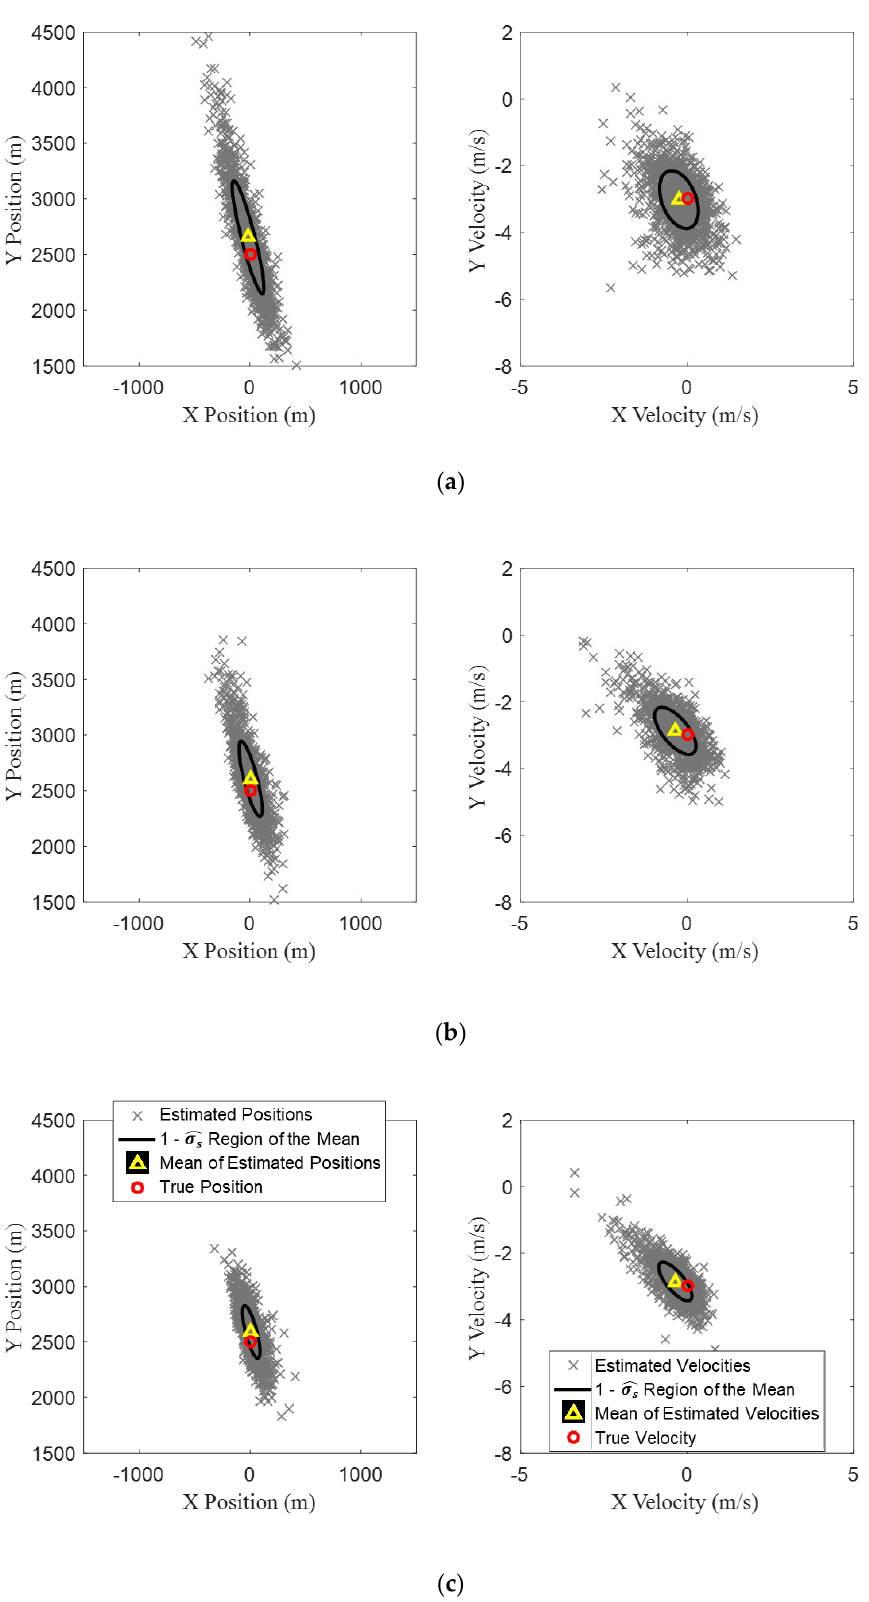
Figure 9. The distribution of initial states estimated using TMA for 1000 random runs with standard deviations of zero mean Gaussian measurement error of 0.4 ° with the measurement numbers of ( a ) 15, ( b ) 30, and ( c ) 60 .